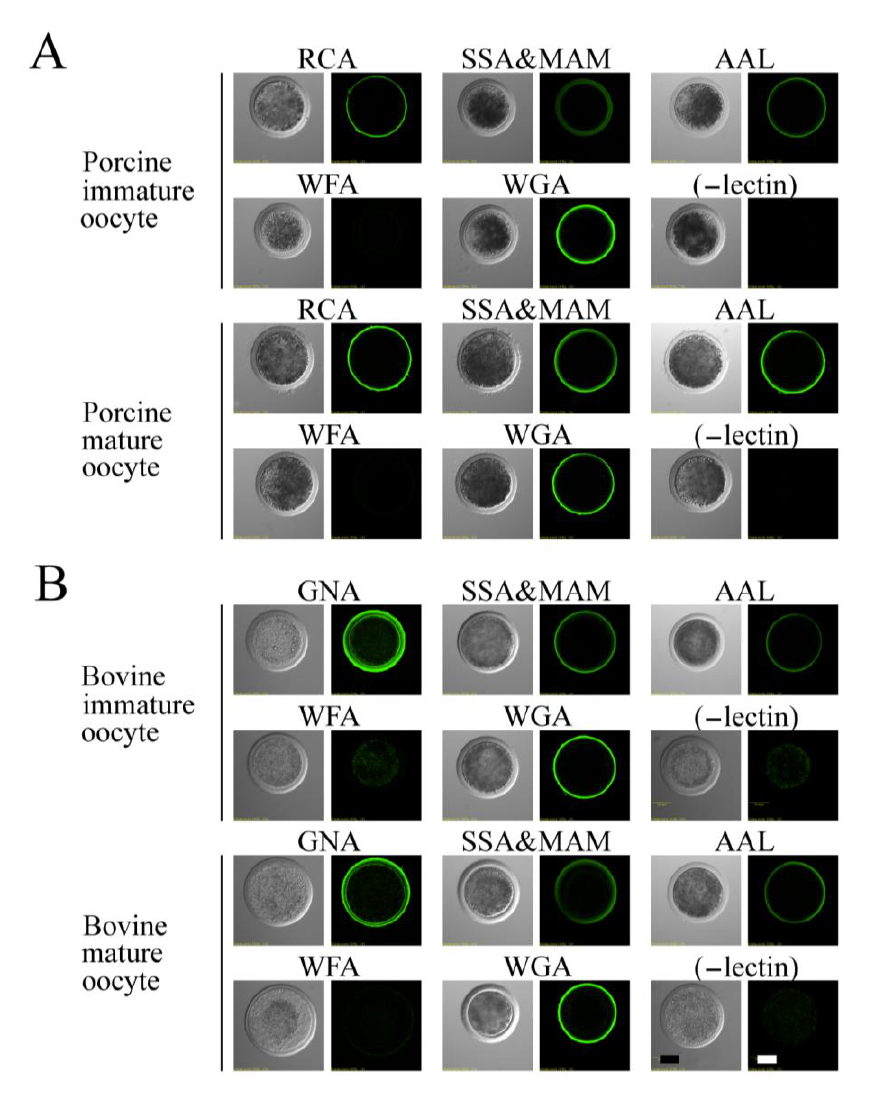
Figure 4. Localization of biotin-conjugated lectins in the porcine and bovine zona pellucida. The porcine ( A ) and bovine ( B ) immature and mature oocytes were incubated separately in BSA/PBS containing biotin-conjugated lectin(s) or without lectins (-lectin) followed by washing and incubation with UltraAvidin–Fluorescein. Left panels, phase-contrast; right panels, fluorescence. Scale bar = 50